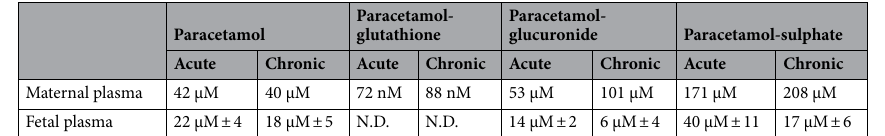
Table 3. The concentration of paracetamol and its metabolites in plasma after acute (single dose; E19) or chronic (5 day twice daily; E15–E19) maternal injection of 15 mg/kg paracetamol. Fetal results are ± S.D. For animal numbers see Fig. 2. N.D. not